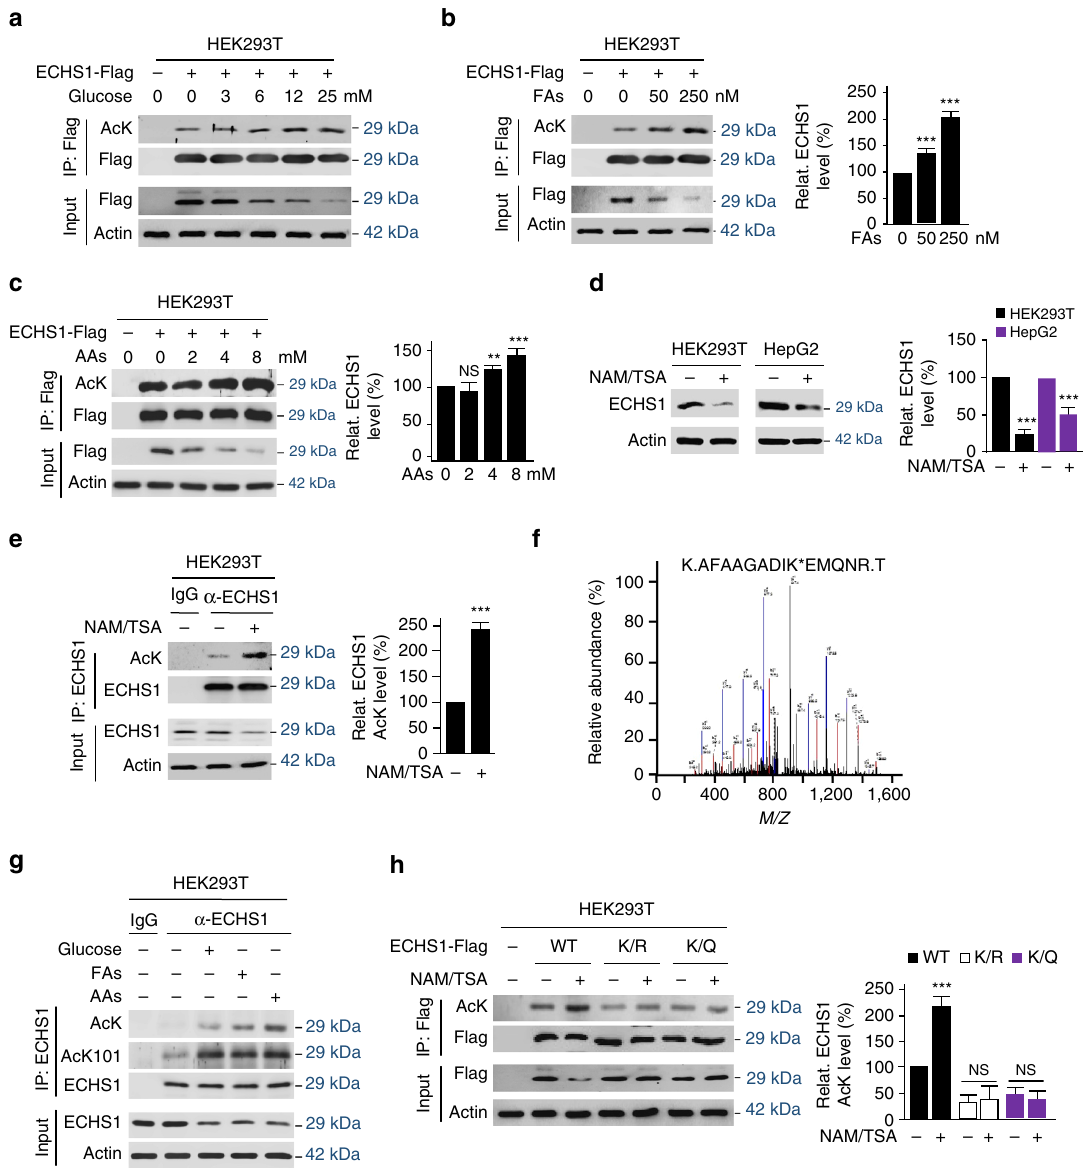
Fig. 2 Nutrients promote ECHS1 K101 acetylation. a – c Western blot detection of acetylation levels of ectopically expressed ECHS1 in HEK293T cell cultured in the presence of excessive glucose ( a ), FAs ( b ), and amino acids ( c ) in the culture media. d Levels of endogenous ECHS1 in HEK293T and HepG2 cells were compared with and without the presence of deacetylases inhibitors NAM/TSA. e Effects of deacetylase inhibitors on the acetylation levels of af fi nity- puri fi ed endogenous ECHS1. f The MS spectrum that led to the identi fi cation of K101 acetylation containing tryptic peptide from endogenous ECHS1. g Western blot detection of proteins levels, AcK levels and AcK101 levels of endogenous ECHS1 in HEK293T cells that were cultured in DMEM base and DMEM base supplemented with glucose (25 mM), fatty acids (250 nM), and amino acids (8 mM). h Flag-tagged wildtype, K101R (K/R), and K101Q (K/Q) ECHS1 were overexpressed in HEK293T cells that were cultured in media with or without NAM/TSA. The relative acetylation levels of ECHS1 proteins puri fi ed from the above mentioned cells using Flag beads was determined. For b – e and h , mean values of quantitation with SD are reported. * P < 0.05; ** P < 0.001; *** P <